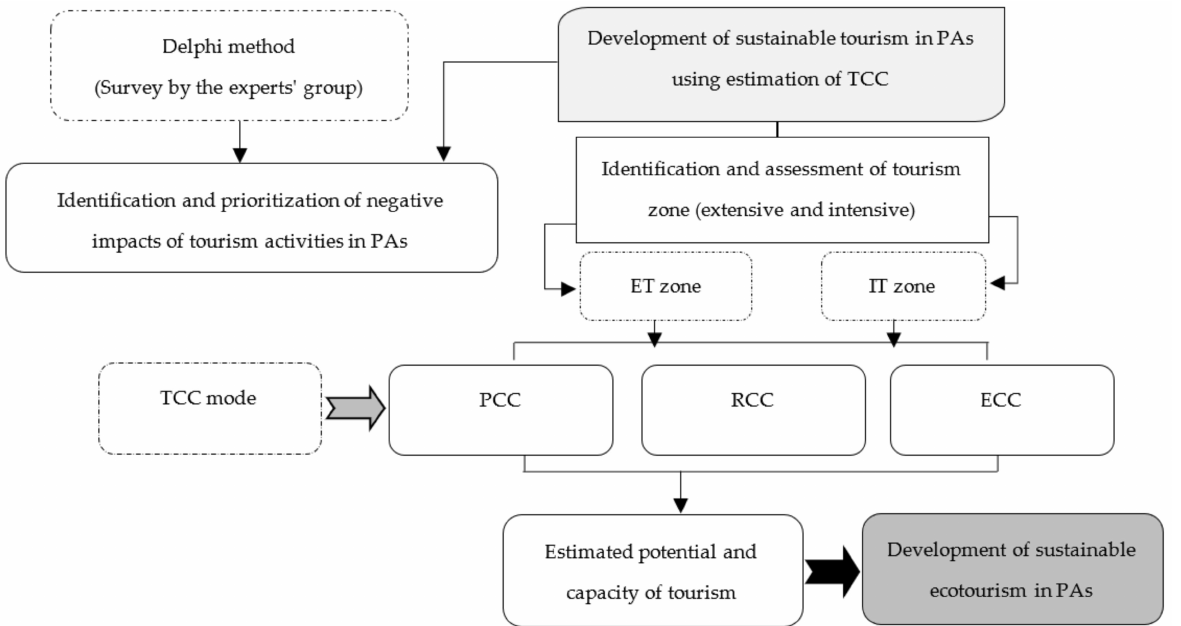
Figure 2. Diagram of the research methodology. PAs—Protected Areas; ET— Extensive Ecotourism; IT—Intensive Ecotourism; TCC—Tourism Carrying Capacity; PCC—Physical Carrying Capacity; RCC—Real Carrying Capacity; ECC—Effective Carrying